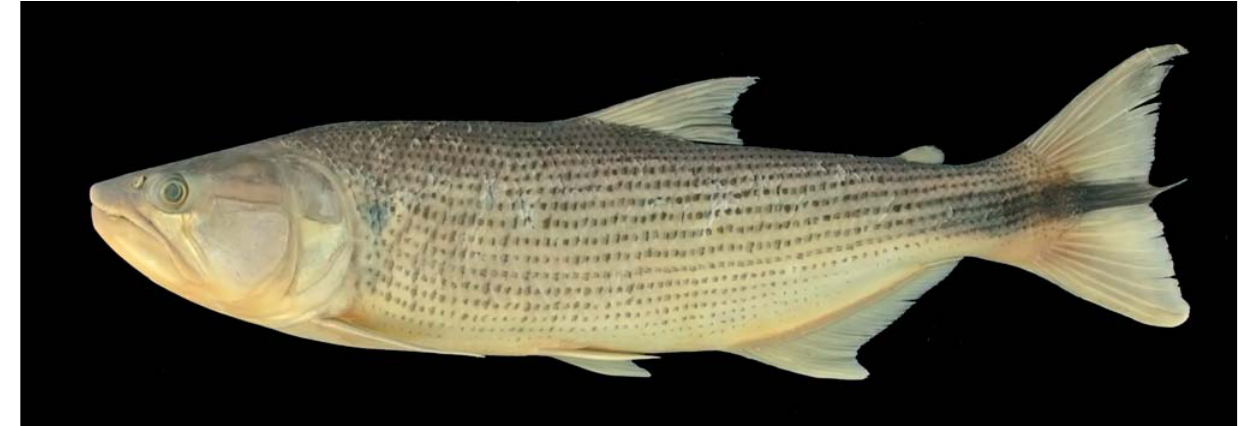
Fig. 1. Salminus franciscanus , holotype, MZUSP 89625, 324.0 mm SL; Brazil, Minas Gerais, stream tributary to rio das